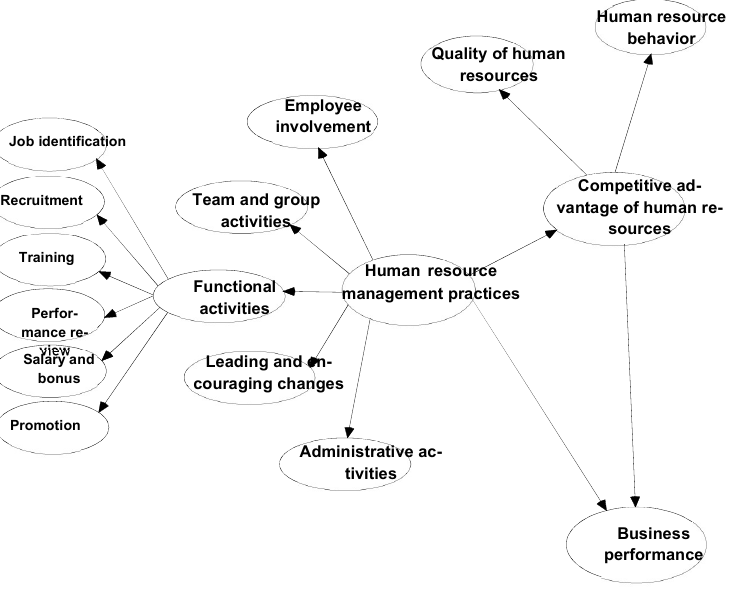
Fig. 2. Theoretical model of the impact of HRMP on competitive advantages and BP of VNPT